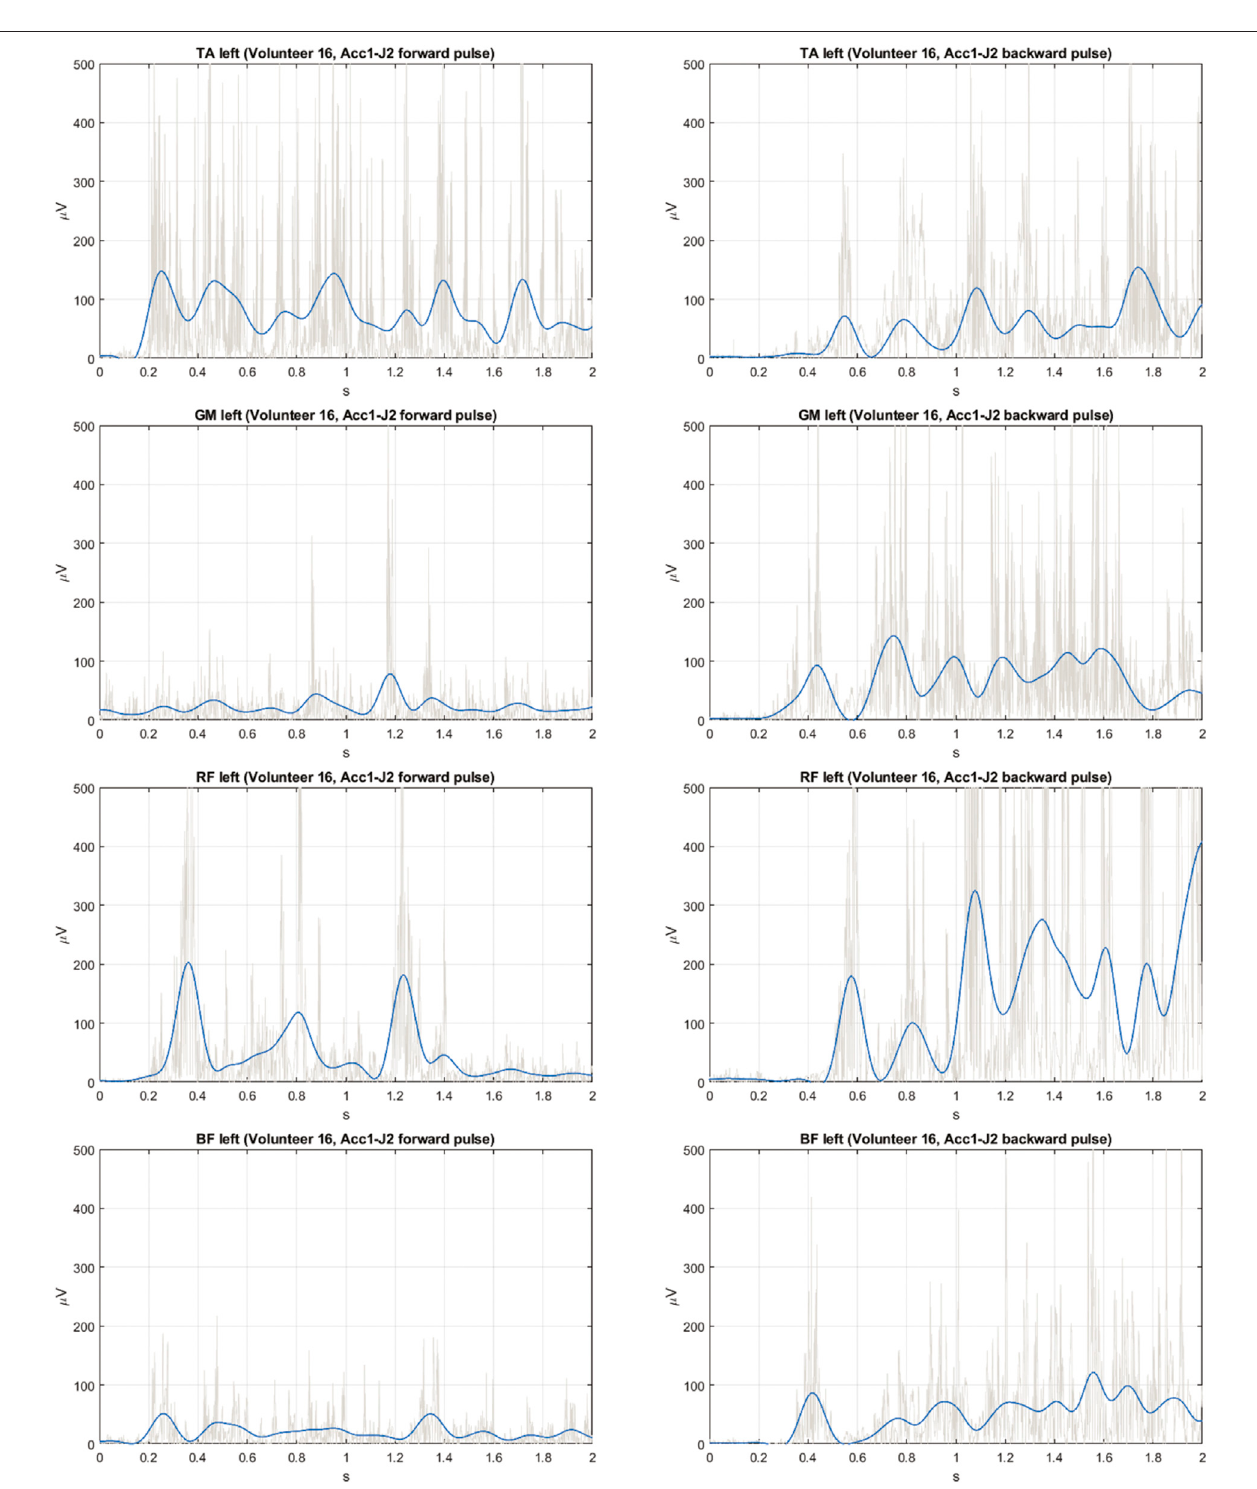
FIGURE 3 | Exemplary EMG signals measured on leg muscles (raw — grey, fi ltered — blue) for the Acc1-J2 pulse in forward direction (left column) and backward direction (right column) ; TA, tibialis anterior; GM, gastrocnemius medialis; RF, rectus femoris; BF, biceps femoris.